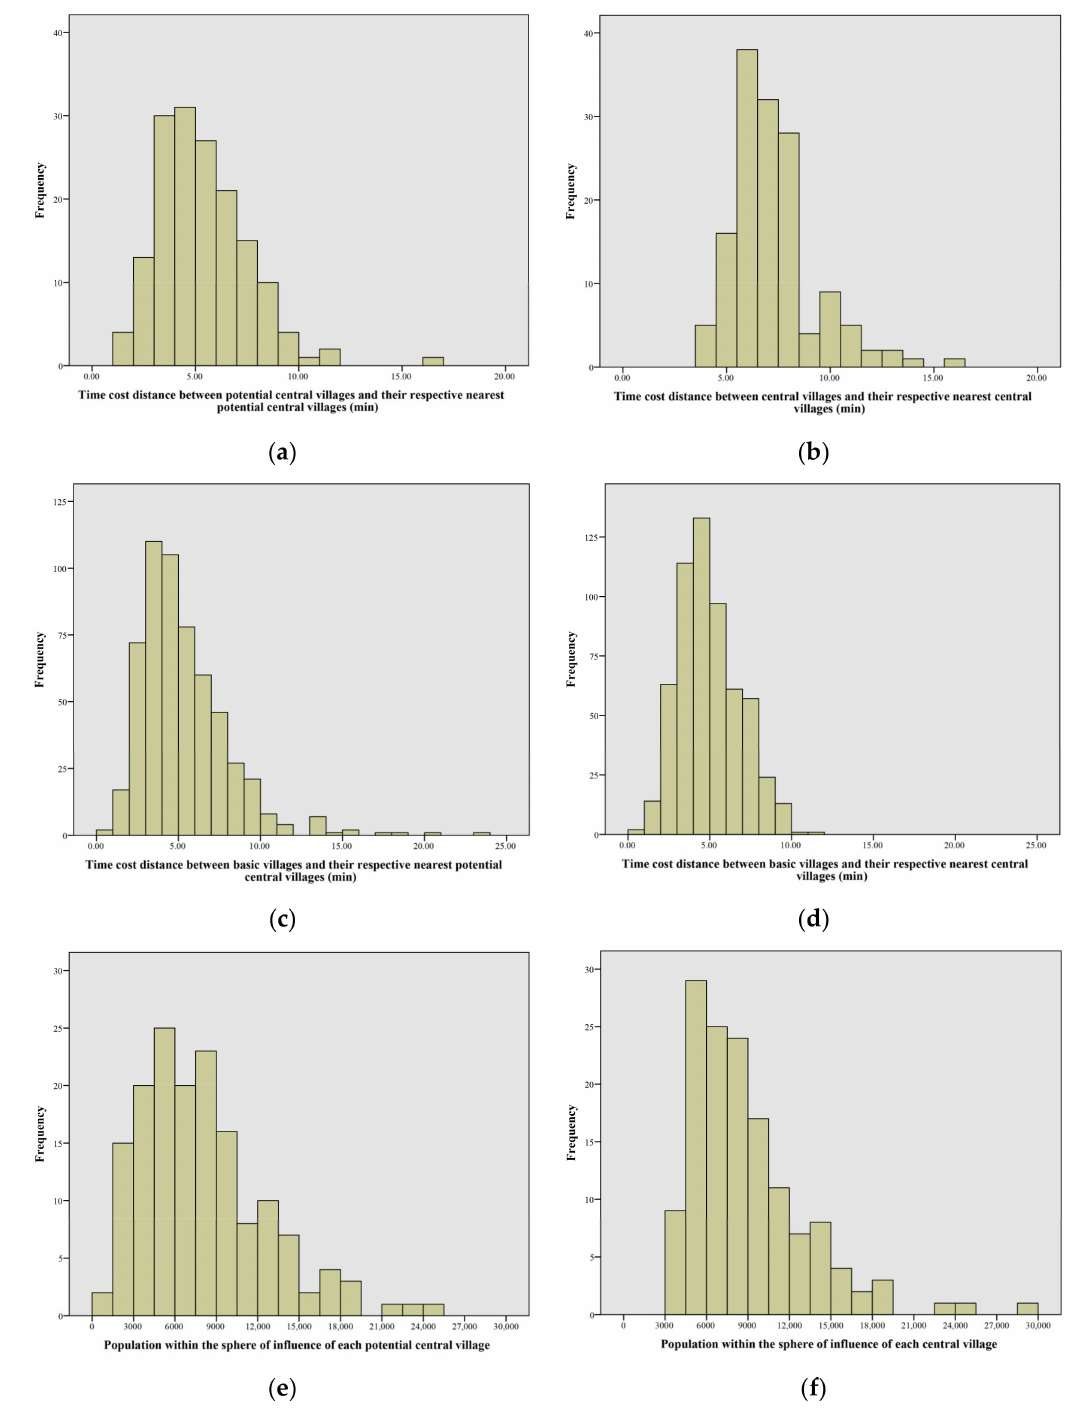
Figure 8. Frequency distribution of indicators related to spatial coverage and equilibrium: ( a ) Time cost distance between potential central villages and their respective nearest potential central villages; ( b ) Time cost distance between central villages and their respective nearest central villages; ( c ) Time cost distance between basic villages and their respective nearest potential central villages; ( d ) Time cost distance between basic villages and their respective nearest central villages; ( e ) Population within the sphere of influence of each potential central village; ( f ) Population within the sphere of influence of each central